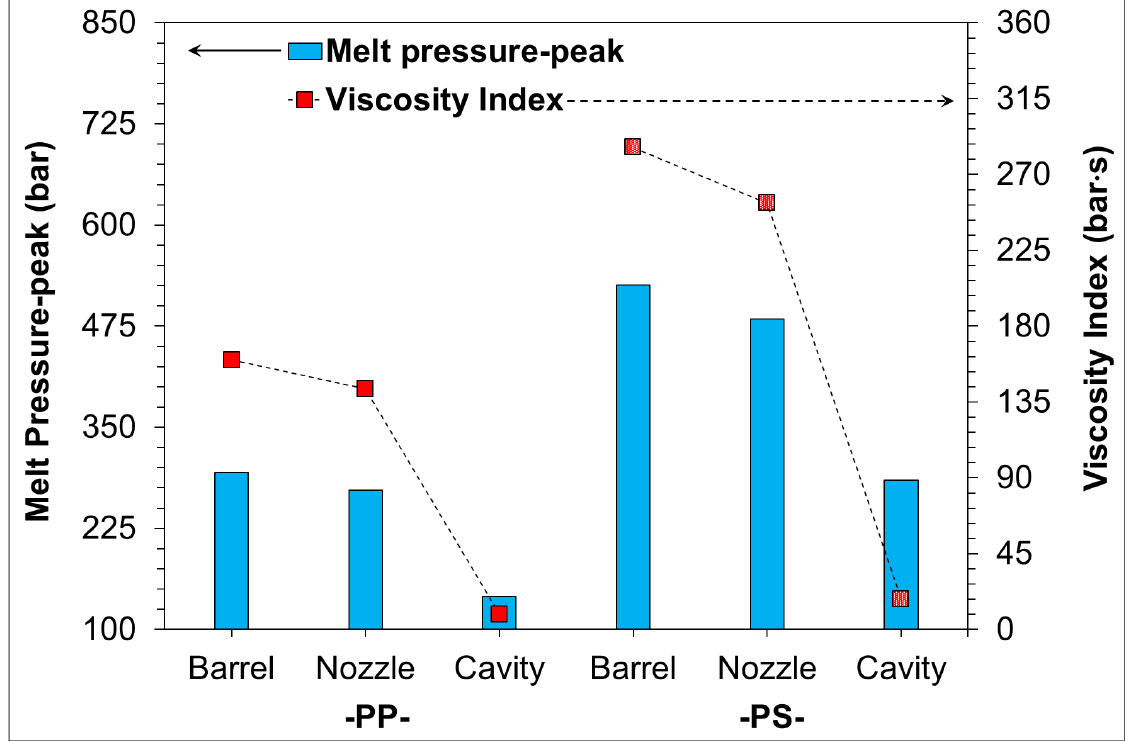
Figure 9. Trend-chart of melting pressure-peak and viscosity index at different positions for PP and PS.